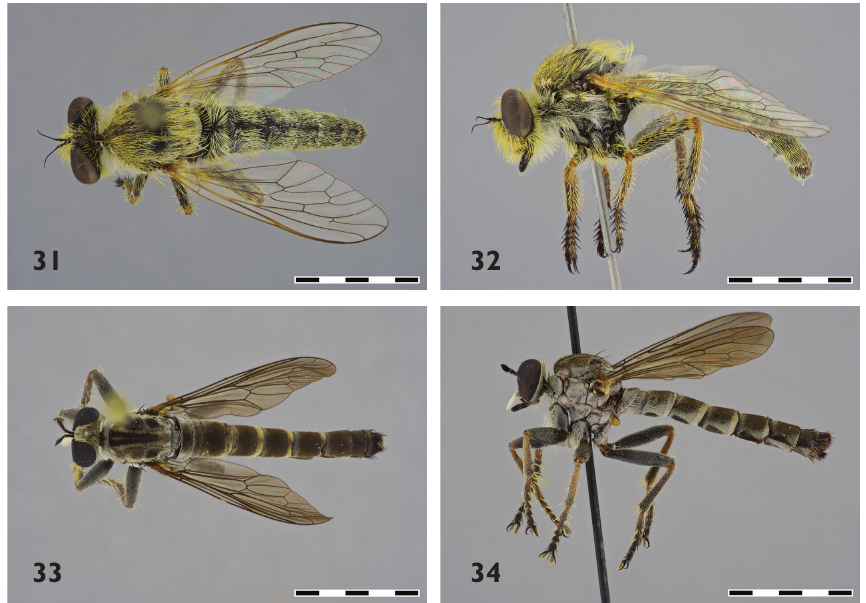
Figures 31–34. Photographs of Willistonininae: 31 male Sporadothrix gracilis Hermann, 1907 (USN- MENT00870183), dorsal (Morphbank #860718) 32 same, lateral (#860720) 33 male Willistonina bilineata (Williston, 1883) (UCRCENT80299), dorsal (#860726) 34 same, lateral (#860728). Scale bars: 5